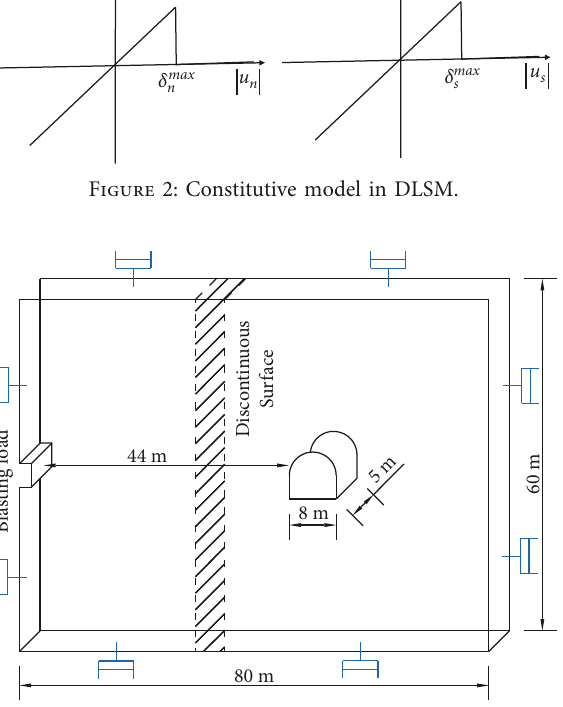
Figure 3: Calculation model